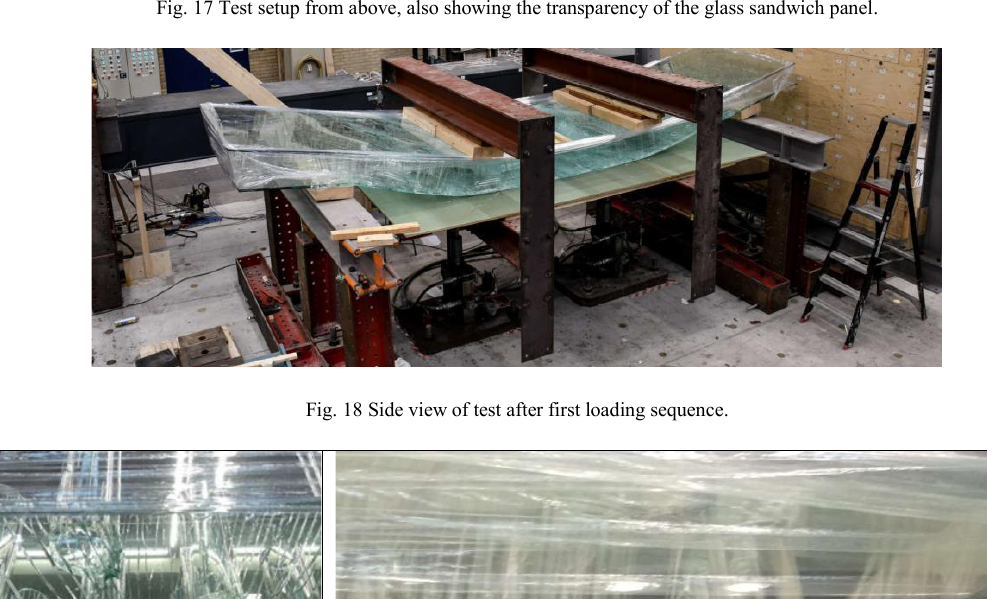
Fig. 19 cracks in bottom plate originating from a spacer.